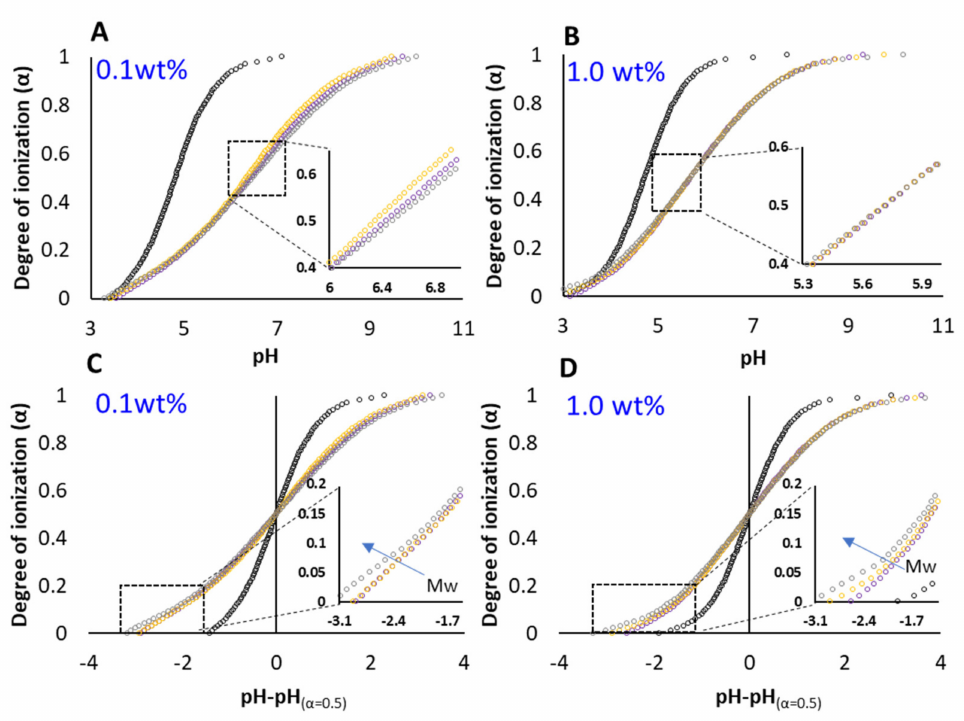
Figure 1. Titration curves presenting the degree of ionization ( α ) as a function of pH: PAc ( black ), PAA 5kDa ( purple ), PAA 30kDa ( orange ) and PAA 100kDa ( grey ). ( A ) PAA 0.1 wt%, ( B ) PAA 1 wt% (dilute solutions, see Table 1). ( C , D ) Degree of ionization ( α ) as a function of ∆ pH (pH- pH( α = 0.5)).